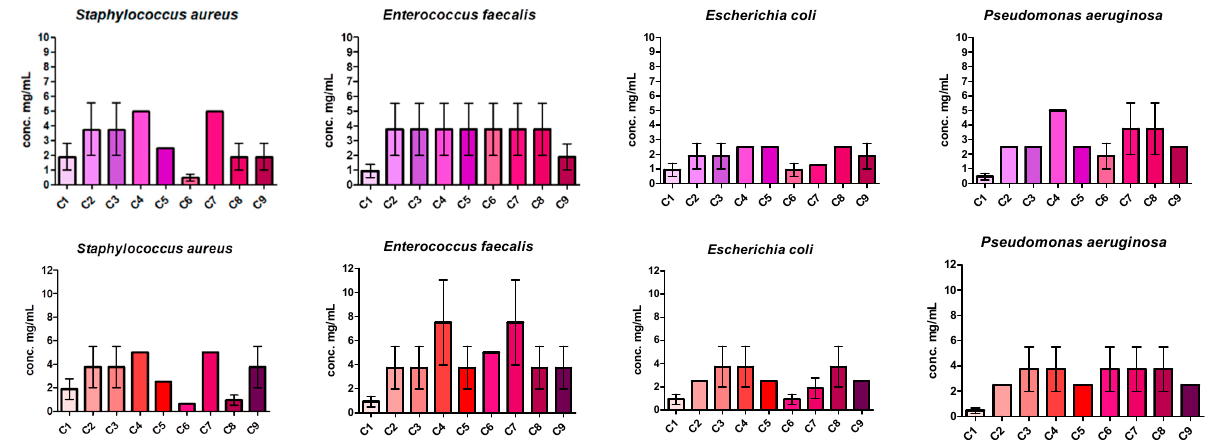
M 0 ) and computed lipophilicity ( log P ).